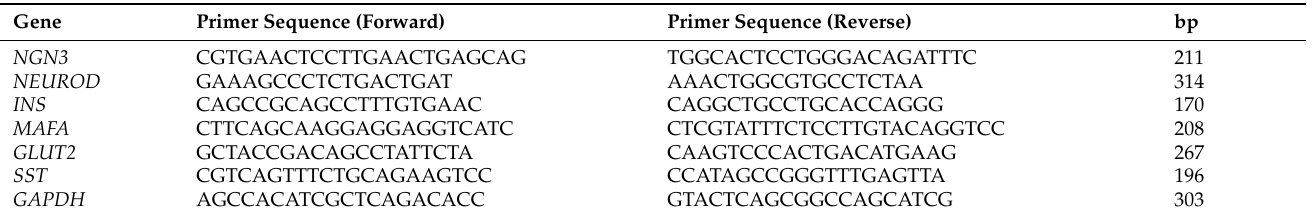
Table 2. Primer Sets for RT-PCR.